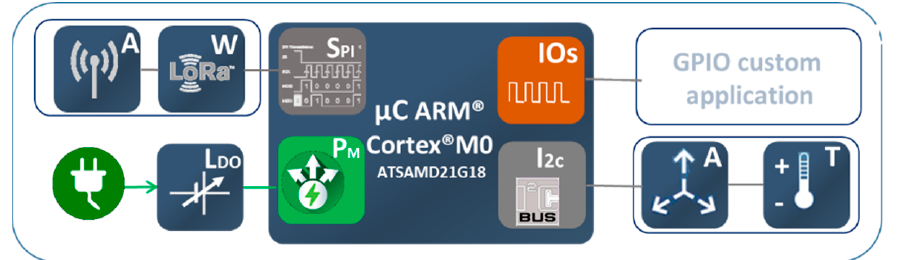
Figure 2. Shows the block diagram of the module, in the center the ARM M0 MCU, ( W ) LoRa transceiver, ( A ) omni-directional antenna, ( Ldo ) power supply and ( AT ) triaxial